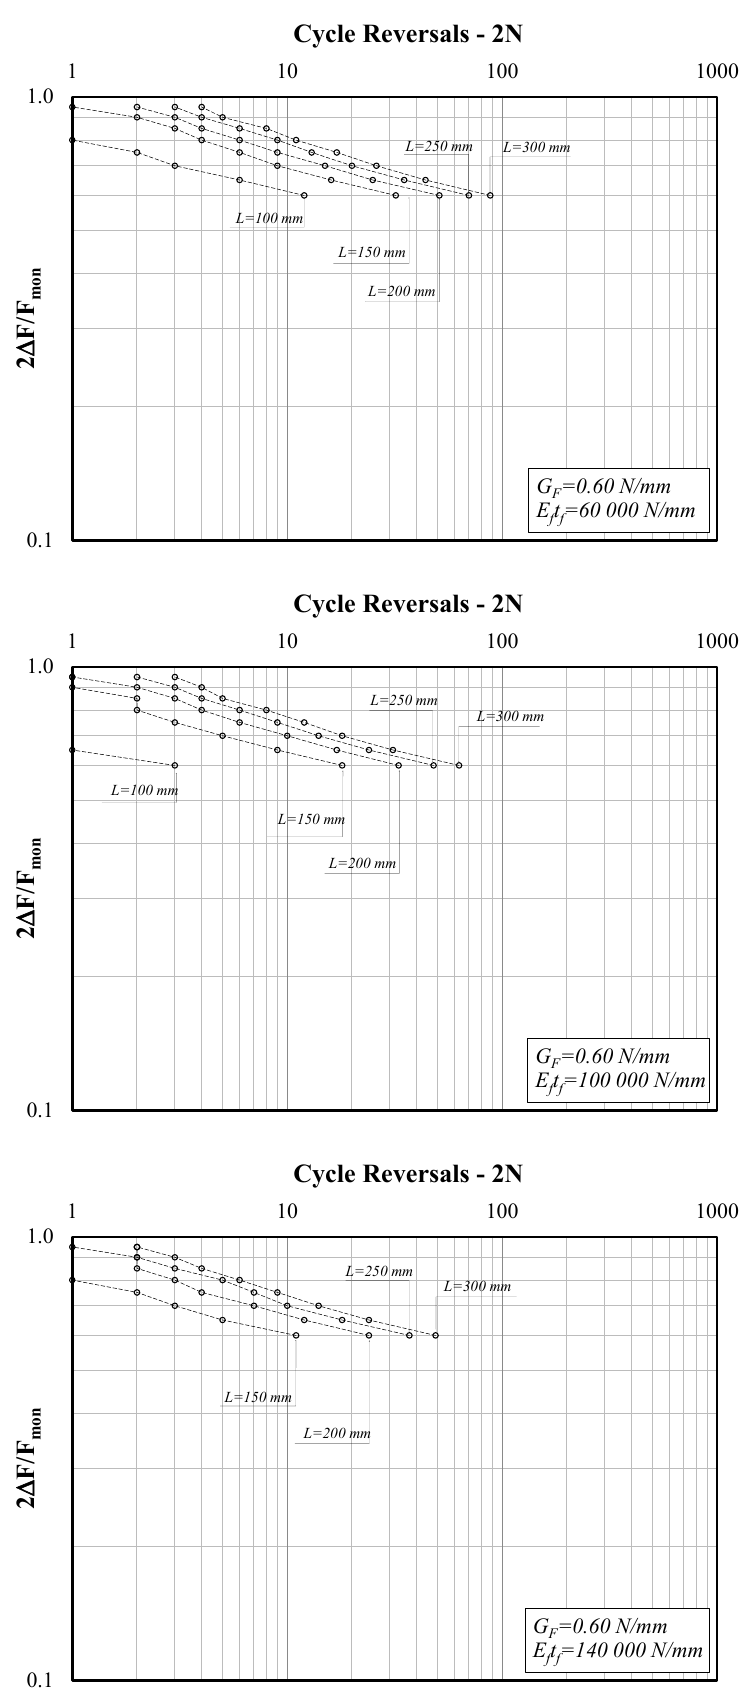
Figure 5. Force amplitude ratio (2 Δ F/F mon ) vs. cycle reversals at debonding (G F = 0.60 N/mm).